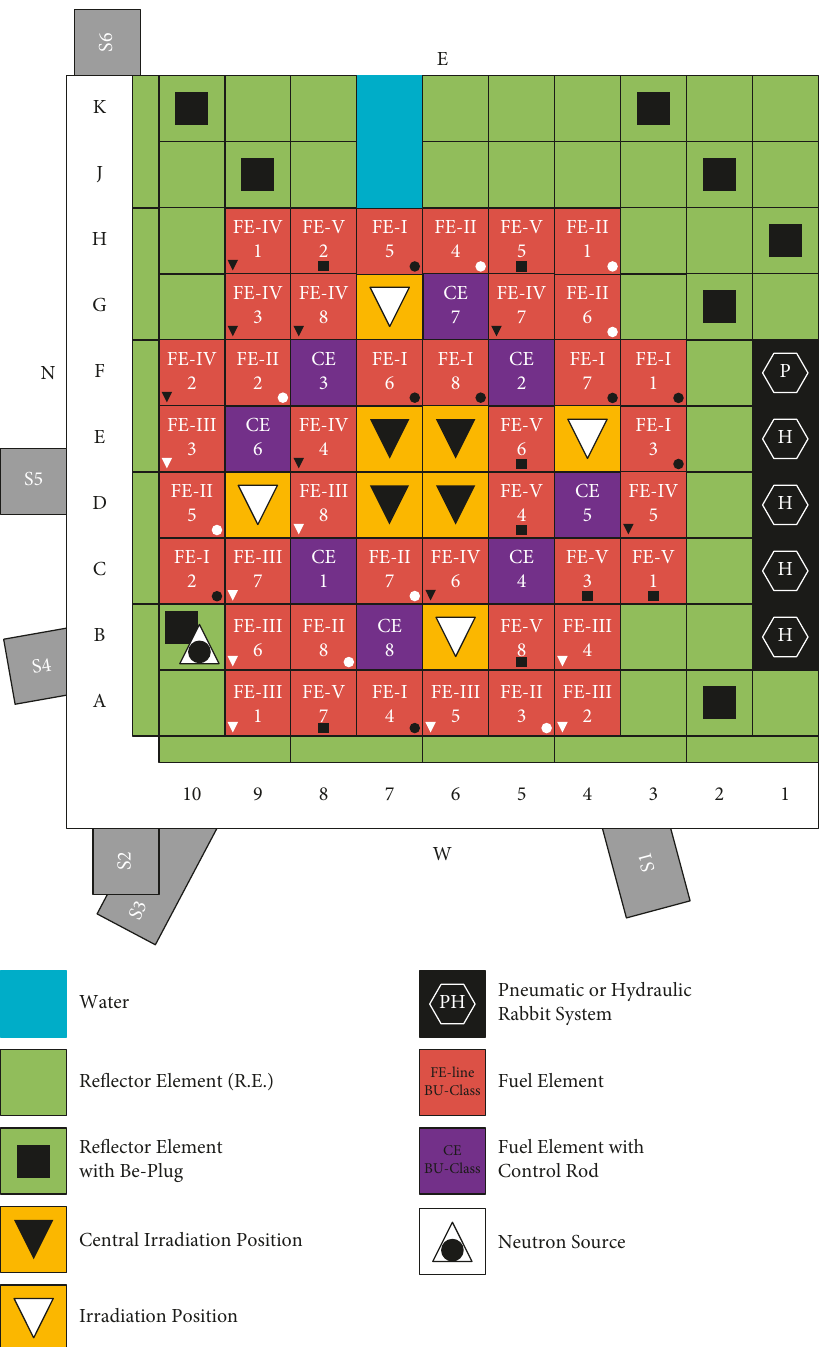
Figure 2: Equilibrium core of the RSG-GAS reactor